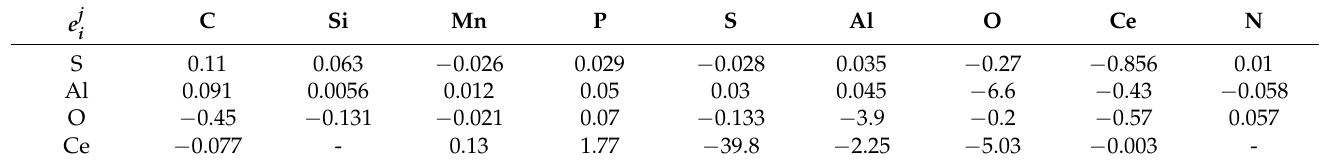
Table 4. The first-order interaction coefficient of each element in molten